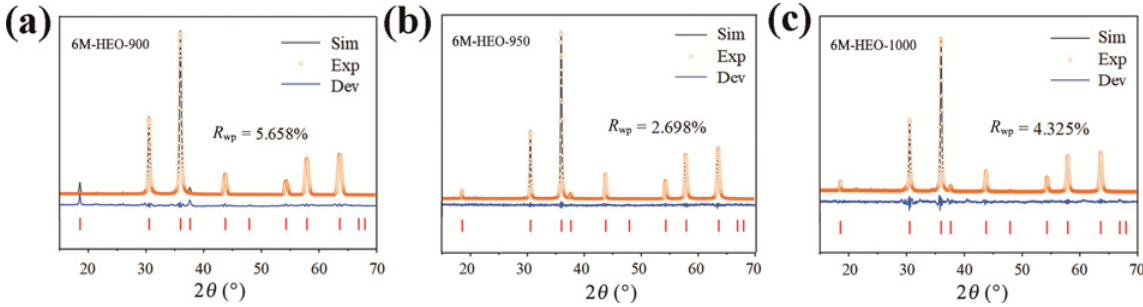
Fig. 2 Typical Rietveld refinement plots of (a) 6M-HEO-900, (b) 6M-HEO-950, and (c)